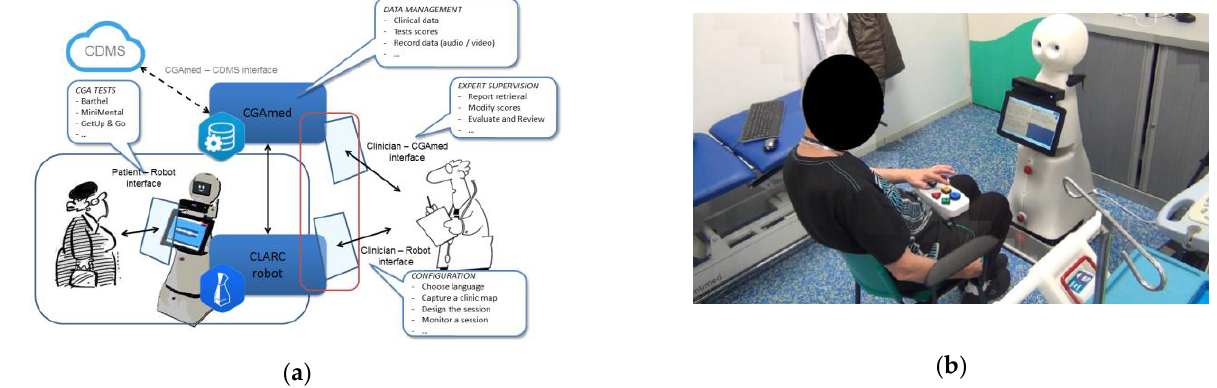
Figure 1. ( a ) Global overview of the CLARC framework; and ( b ) real patient interacting with robot .